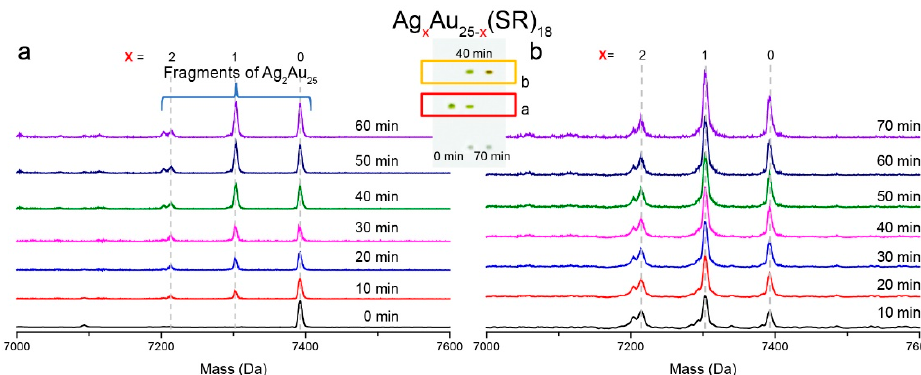
Figure 3. Time-dependent MALDI-TOF-MS spectra of the Ag 2 Au 25 (SR) 18 reaction with PET. The inset Figure 3. Time ‐ dependent MALDI ‐ TOF ‐ MS spectra of the Ag 2 Au 25 (SR) 18 reaction with PET. The inset